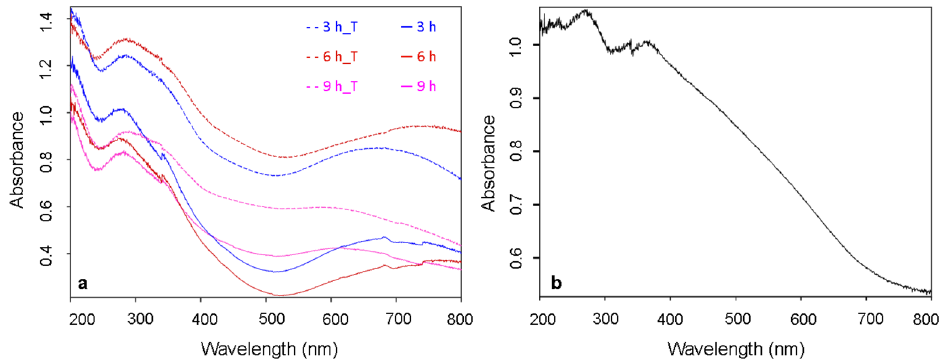
Figure 7. Absorption spectra of ( a ) copper surfaces immersed in 0.033 M ammonia solution for 3-9 h before and after thermal treatment (marked with the ‘T’ index); ( b ) Cu 3 N film.